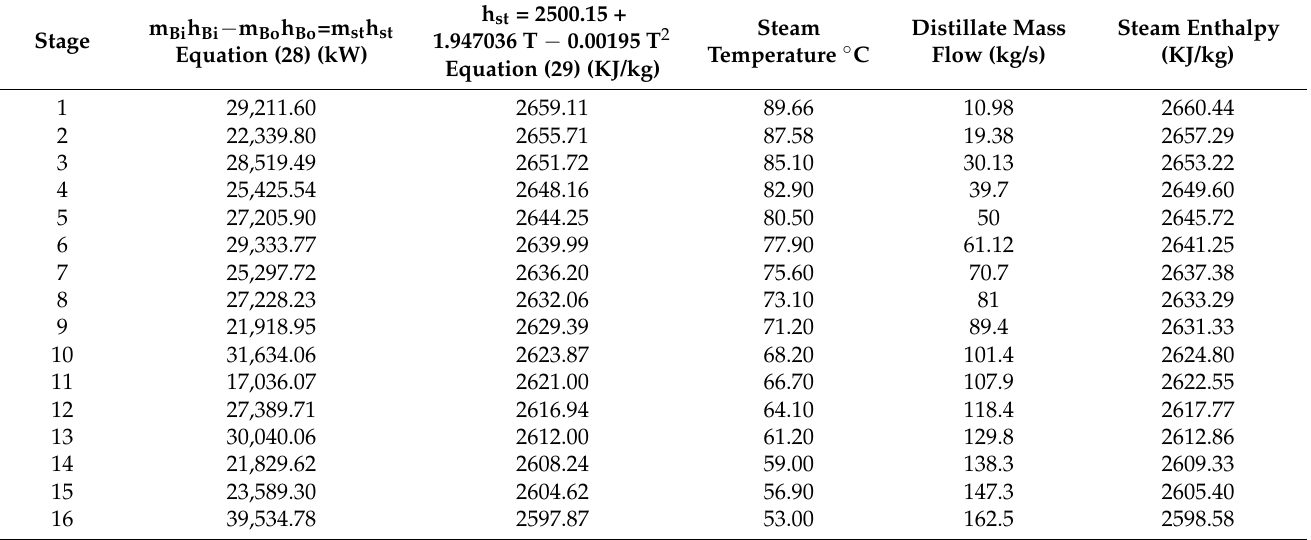
Table 3. Evaluated steam temperature by iteration using Equations (28) and